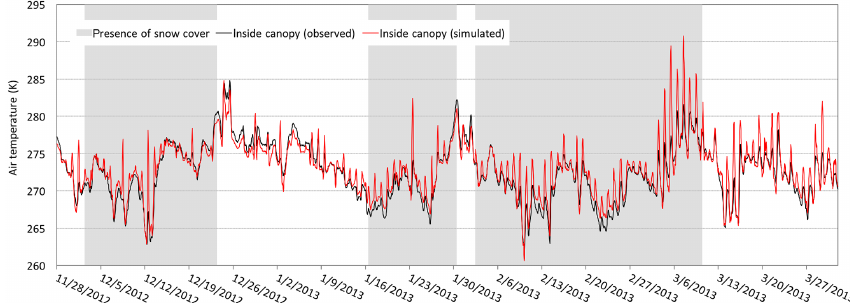
Figure 7. Simulated and observed temperature inside the forest canopy for the winter period 2012/13 at site Vordersteinwald. The grey areas indicate periods with presence of a snow cover.